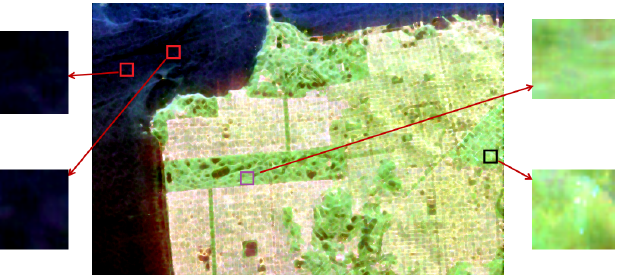
Figure 2. In a PolSAR image, it may be hard to distinguish two patch samples whenever they come from the same land cover type (the left two) or not (the right two).